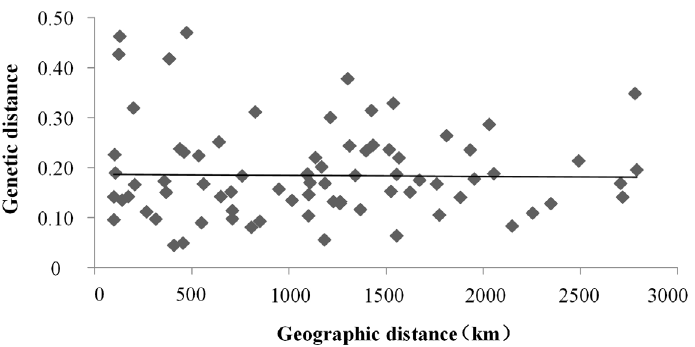
Figure 5. The non-significant linear regression between genetic distance and geographic distance based on eleven microsatellite loci in the clam samples (Y = −5.41 × 10 −6 X + 0.1959, R 2 = 0.0018, 10,000 permutations).